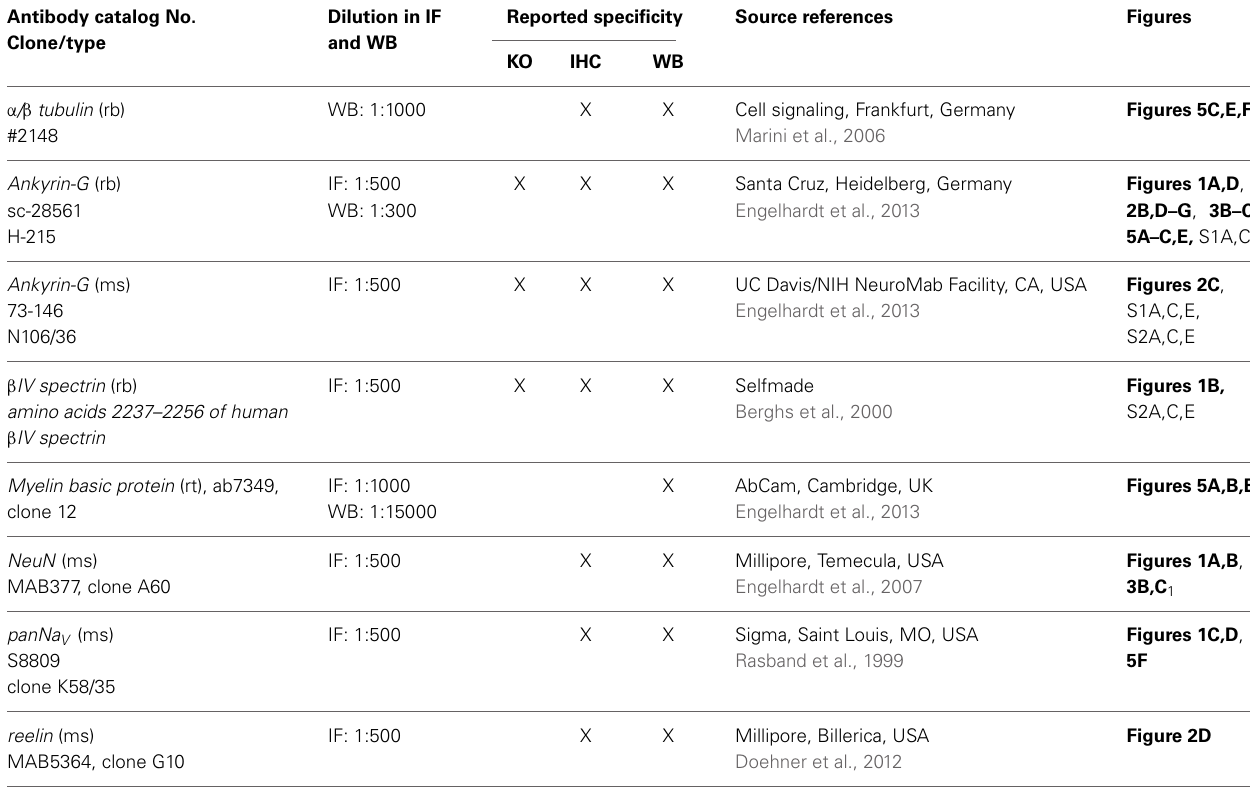
Table 2 | Specification of antibodies with indication of catalog number, clone, working dilution, previously conducted controls, sources and references where available, and the corresponding figure in the manuscript.